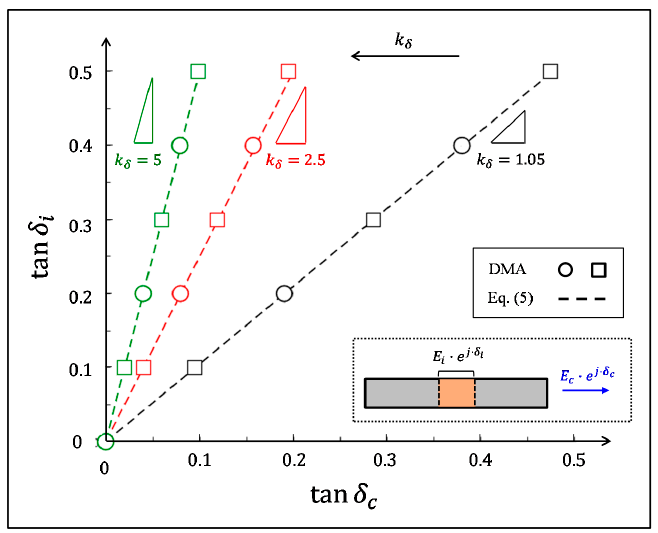
Figure 3. The correspondence between tan δ i and tan δ c for various biocomposite configurations. The dashed lines indicate the theoretical results via Equation (4), and the symbols indicate the corresponding finite-element results (Table S2 in Supporting Information). The colors indicate data sets with the same k δ parameter: black, red, and green correspond to k δ = 1.05, 2.5, and 5, respectively. The range of tan δ i spans between completely elastic (tan δ i = 0) and predominantly viscoelastic (tan δ i = 1/2)